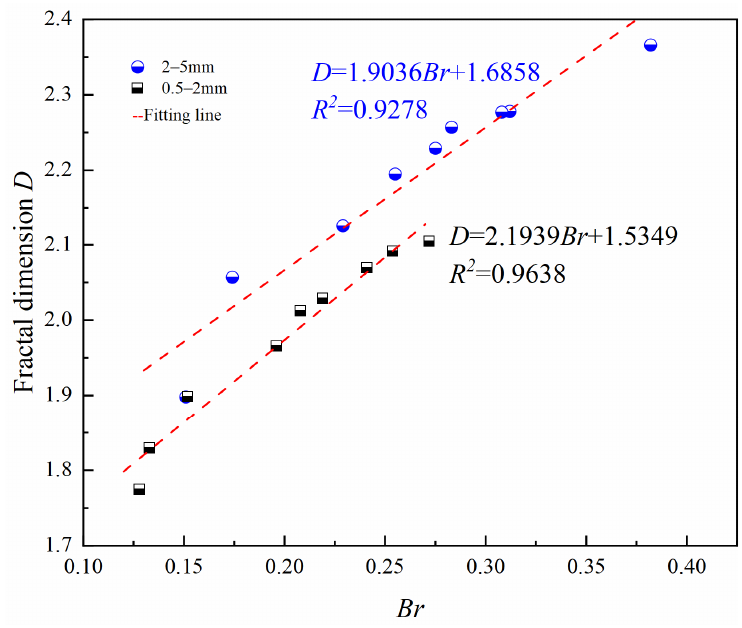
Figure 17. Variations in Fractal dimension ( D ) with relative breakage rate ( Br ).